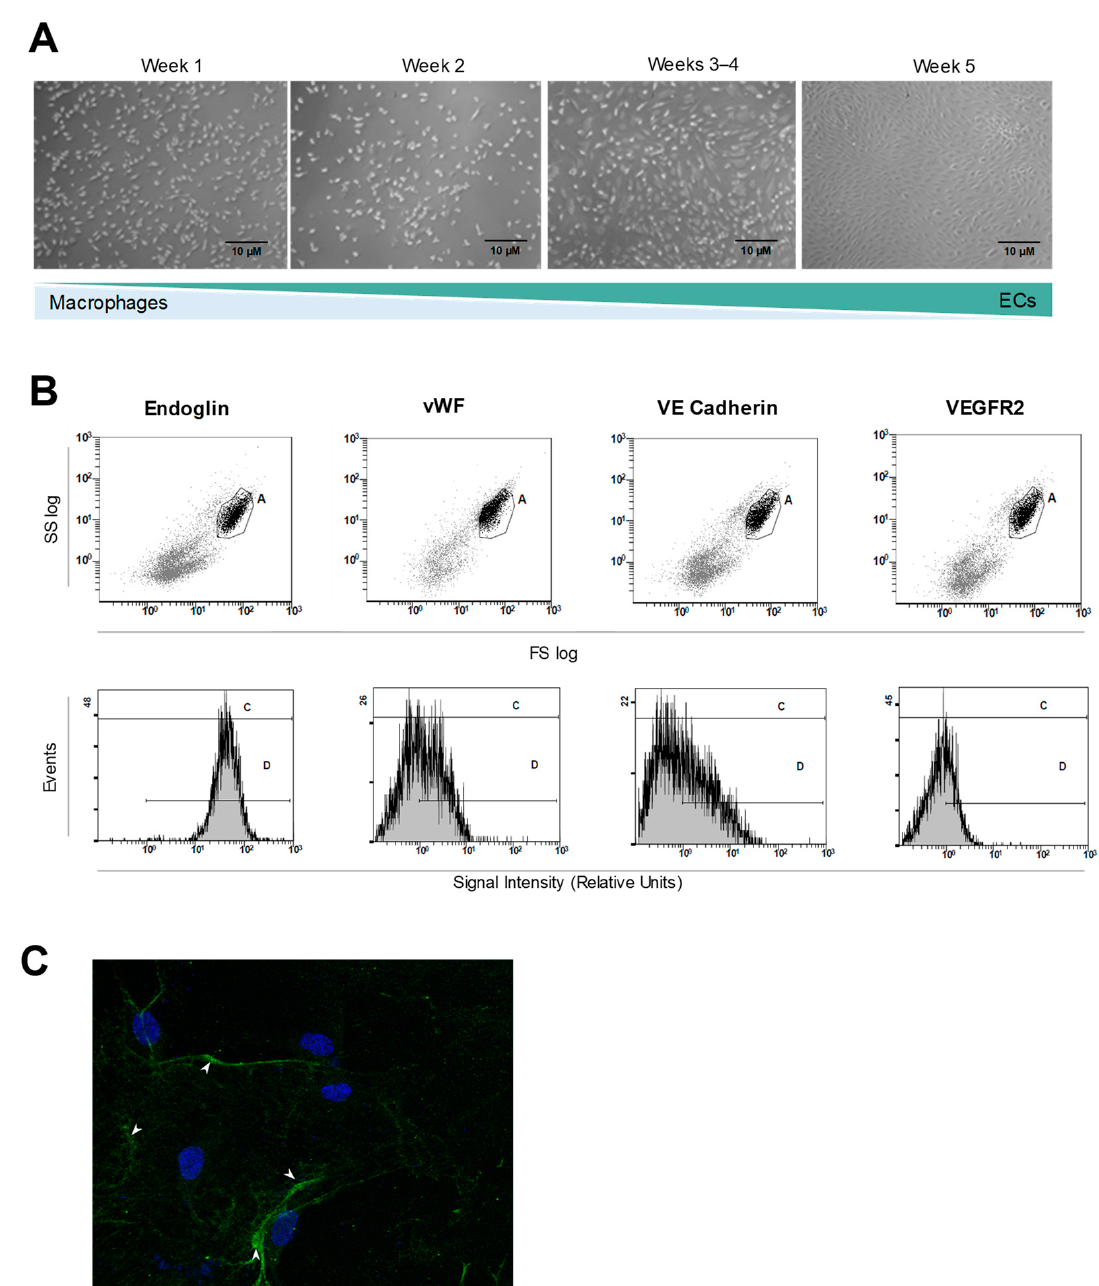
Figure 1. ( A ) Isolation of ECs derived from periphery blood samples (BOECs). Photograph sequence of BOECs culture growth and expansion, weeks 1 through 5. As days pass and cell medium is changed, macrophages die and leave room for ECs expansion. These images are representative of EC culture isolation from both patients and healthy donors. ( B ) Flow cytometry characterization of the ECs obtained after week 5 of expansion, using EC markers: Endoglin, VWF, VE Cadherin, and VEGFR2. Graph shows expression index of all four markers, as product of the intensity and the % of positive cells. ( C ) VWF localization inside the isolated ECs, in Weibel Palade bodies, as seen by confocal microscopy (green). The nuclei are in blue from DAPI staining.